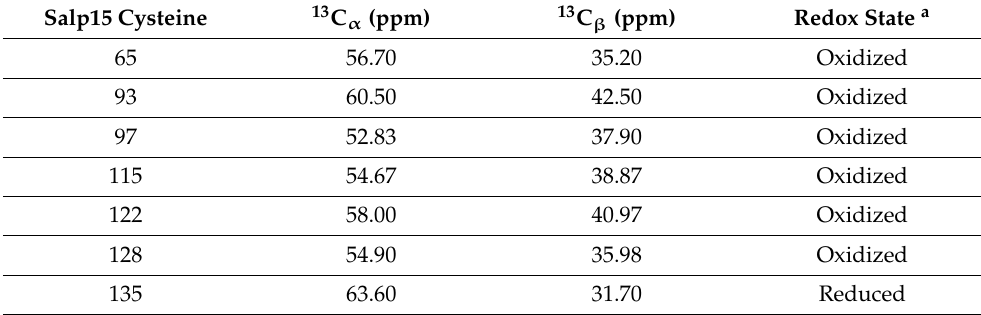
Table 1. Chemical shifts of the 13 C α and 13 C β resonances of cysteines in Salp15.